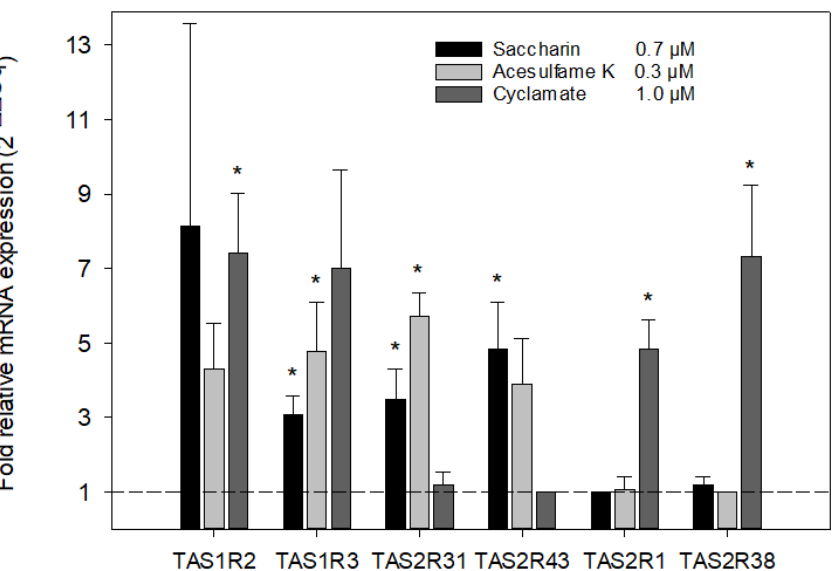
Figure 4. Relative transcript levels for sweet and bitter taste receptors in isolated neutrophils after stimulation with typical plasma concentrations of NNS in vitro. Isolated neutrophils from buffy coat samples were incubated with the different sweeteners at plasma-typical concentrations for 24 h, as indicated. Transcript levels were obtained from RT-qPCR and are given as 2 − ∆∆ Cq , normalized to the lowest signals for each sweetener, respectively (dashed line), which always corresponded with their non-cognate receptors: Saccharin–TAS2R1, Acesulfame K–TAS2R38, Cyclamate–TAS2R43. Data are shown as mean ± SEM. Differences in receptor transcript levels were tested for each sweetener versus its respective minimum by paired t -test ( n = six blood samples; * p < 0.05, two-tailed).